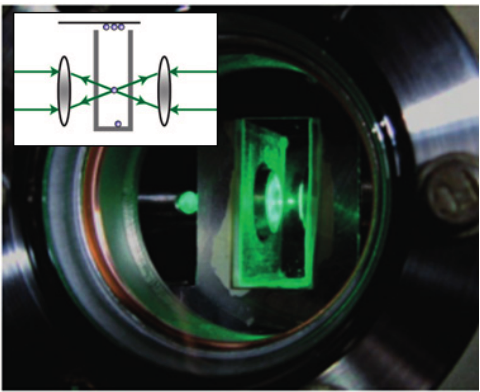
Figure 2. A 4.7 μ m diameter microsphere trapped inside a vacuum chamber by a counter-propagating dual-beam optical tweezer. The wavelength of the trapping beams is 1064 nm; A weak green (532 nm) laser is used for illumination. Inset is a counter-propagating dual-beam optical trap in air based on radiative pressure forces. With kind permission from Springer Science and Business Media